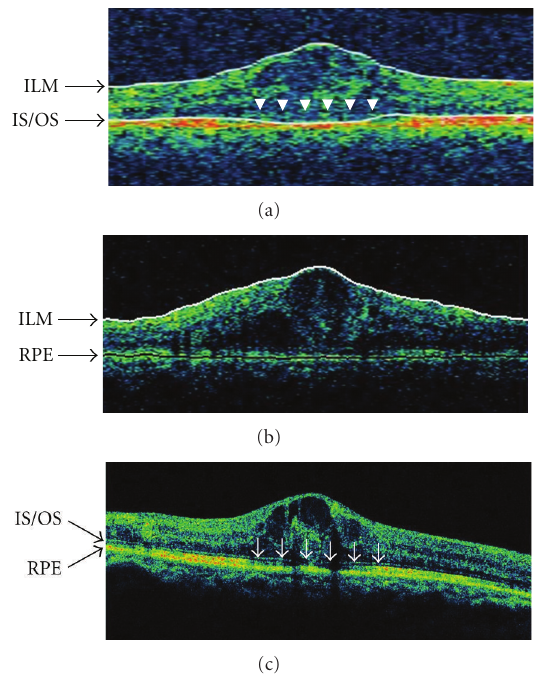
Figure 4: The ILM and IS/OS are traced by a white line using TD- OCT, although the true IS/OS line is thought to be that indicated by the arrowheads in the retinal thickness mode (a). The ILM and RPE are traced by a white and black line by the macular thickness mode of SD-OCT (b). The IS/OS line is indicated by a vague line in the five-line mode (arrowheads) (c).